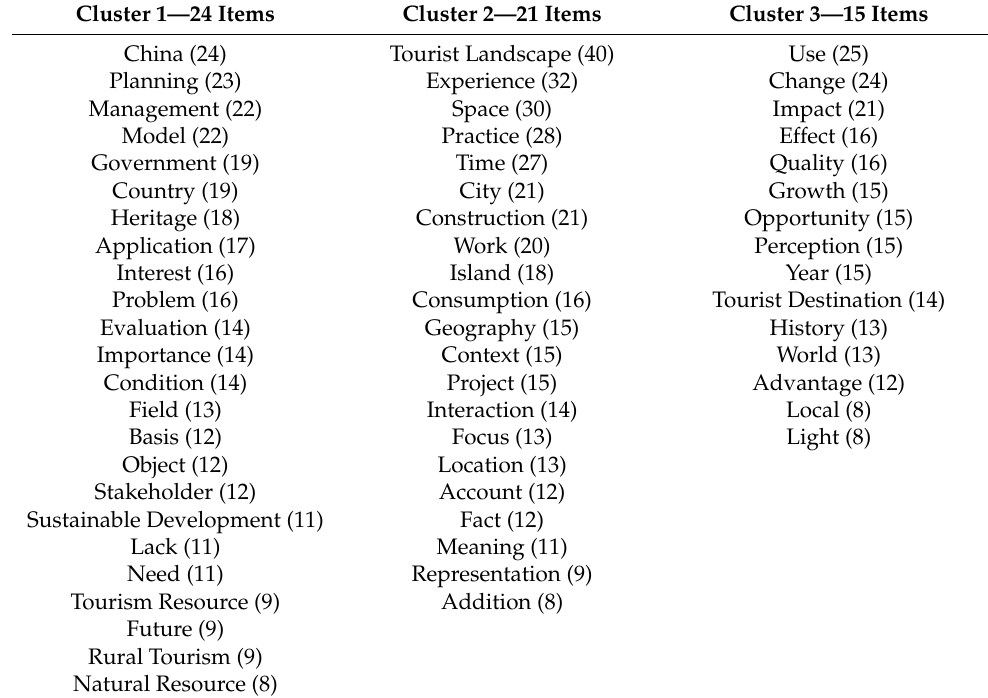
Table 2. Items with the number of occurrences in parentheses for each cluster calculated by